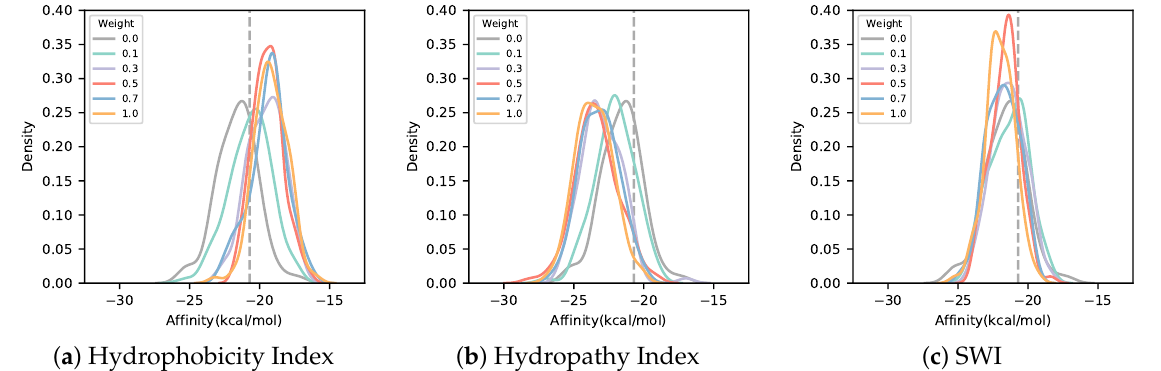
Figure 5. Distribution of binding affinity for various weights of sequences designed in AfDesign using three solubility indices. The binding affinity of sequences designed in AfDesign using the Hy- drophobicity Index ( a ), Hydropathy Index ( b ), and Solubility-Weighted Index (SWI) ( c ) as solubility indices in the loss function. Each color indicates the weight of the solubility loss. The gray line with a weight of 0.0 shows the distribution of binding affinity for the sequence designed by AfDesign without a solubility index. The dashed line shows the average of binding affinity of the p53 peptide.